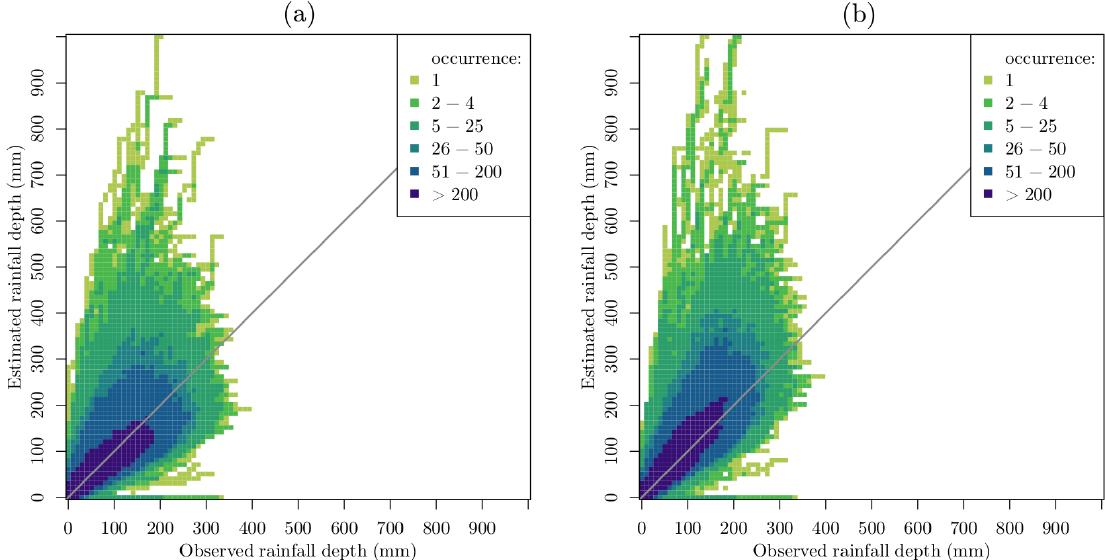
Figure 6. Density plots of the double-mass curves of all individual CMLs with respect to the gauge-adjusted radar reference at 15min time intervals: (a) rainfall accumulation retrieved by RAINLINK with calibrated parameters; (b) rainfall accumulation retrieved by RAINLINK with default